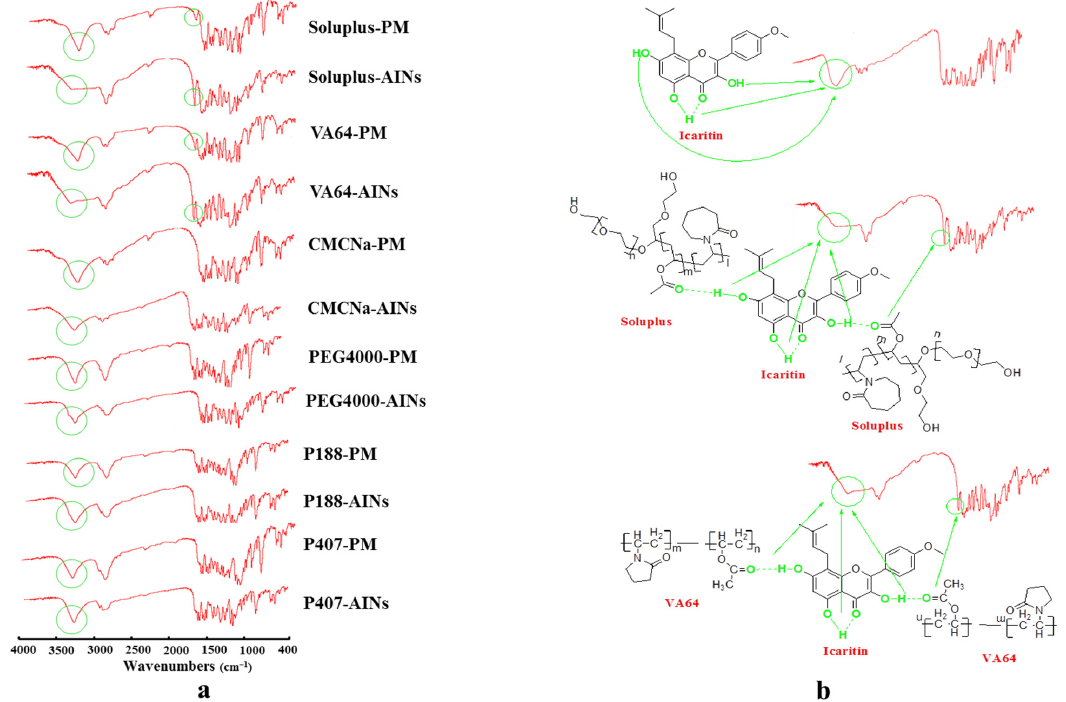
Figure 5. FTIR spectra of AINs and physical mixtures (PM) of icaritin and polymers ( a ), and the mechanisms of interaction between icaritin and polymers ( b ). AINs: amorphous icaritin nanoparticle; FTIR: Fourier transform infrared spec- troscopy.